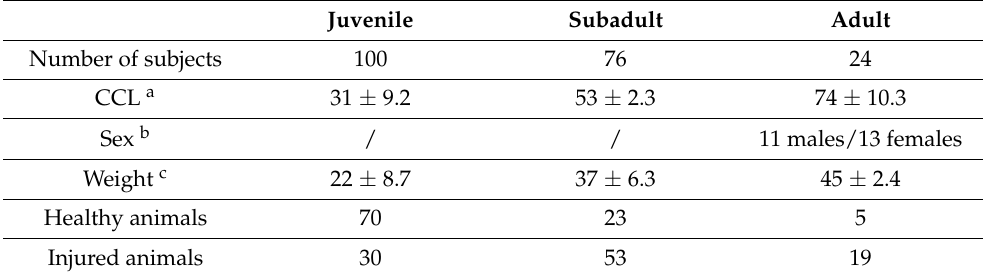
Table 1. Major features of healthy and injured loggerhead sea turtles included in the study (200